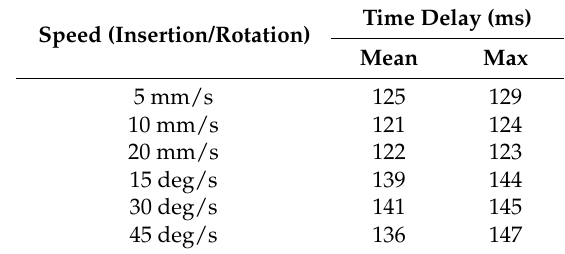
Table 3. Time delay between the master haptic interface and the catheter manipulator.